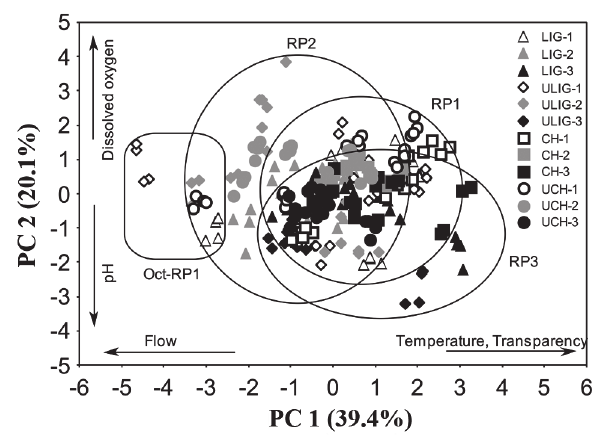
Fig. 3. Principal Components Analysis of the environmental variables’ matrixes recorded in the upper Uruguay River between October 2001 and March 2004. Sampling sites: LIG: Ligeiro, ULIG: Uruguay-Ligeiro, CH: Chapecó and UCH: Uruguay-Chapecó. Reproductive Periods: RP1: First Reproductive Period, RP2: Second Reproductive Period and RP3: Third Reproductive Period.